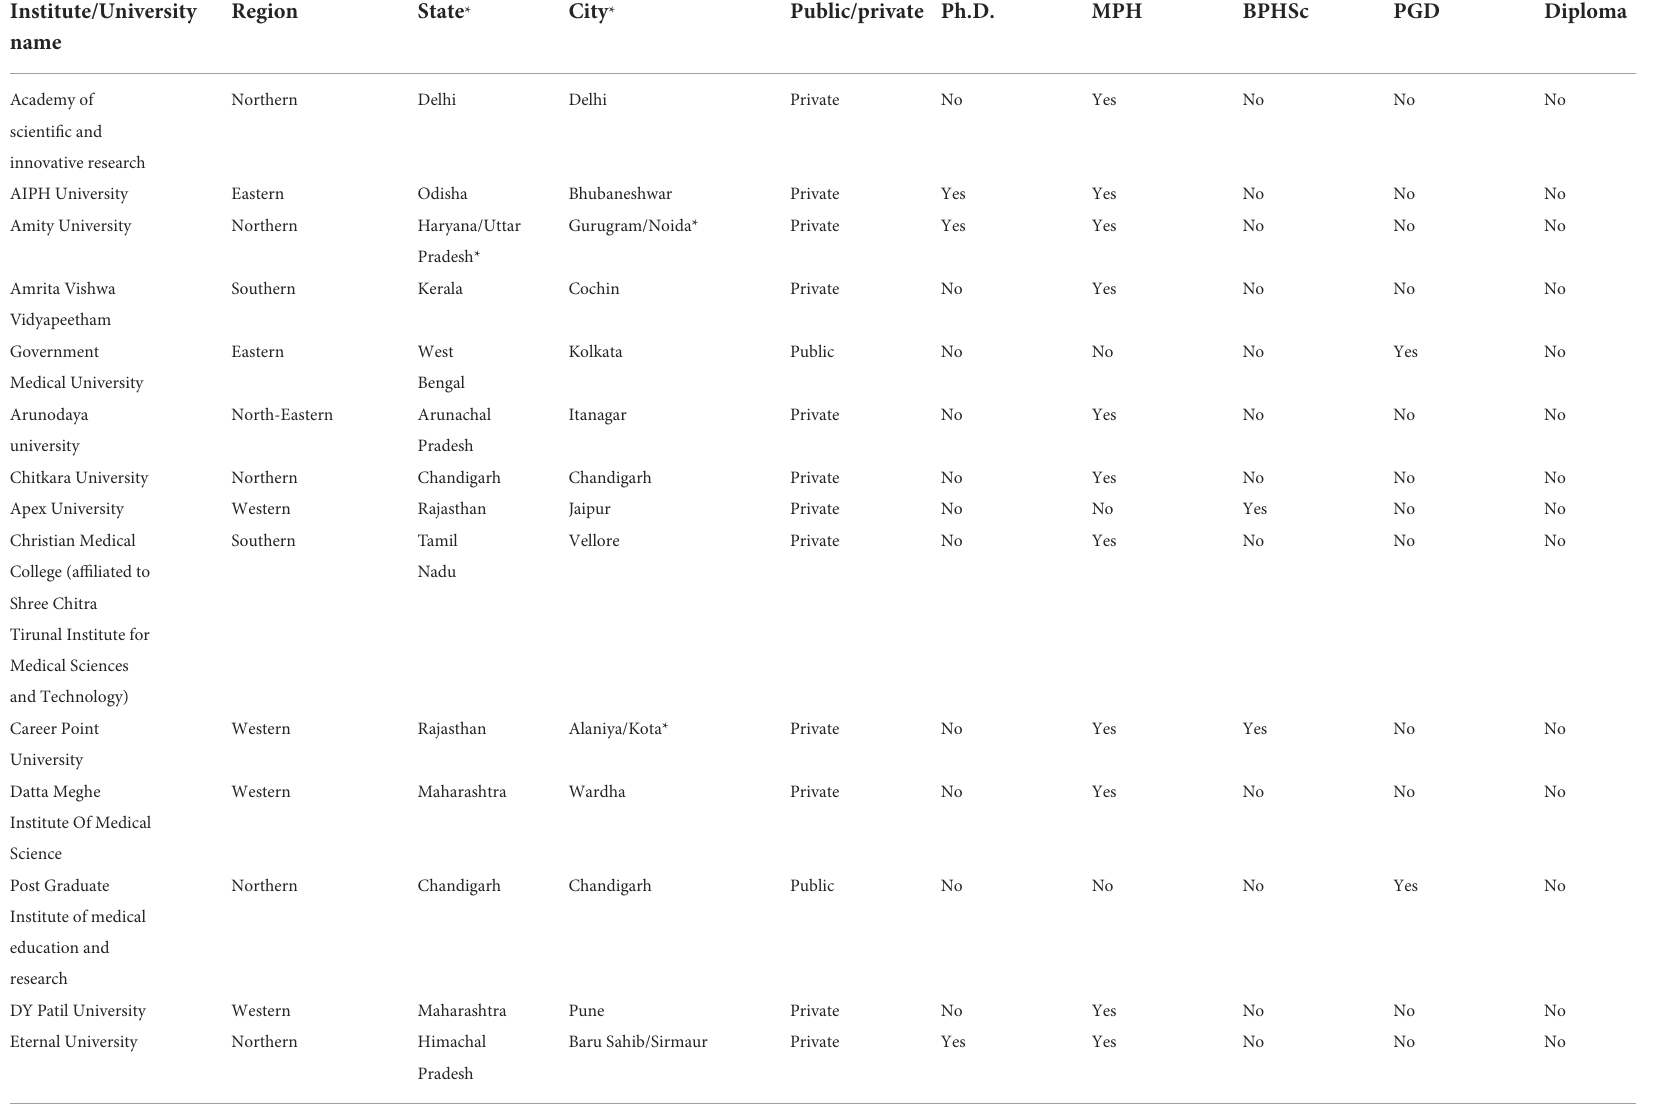
TABLE 2 List of unique institutes/universities offering public health programs across India ( n = 84).